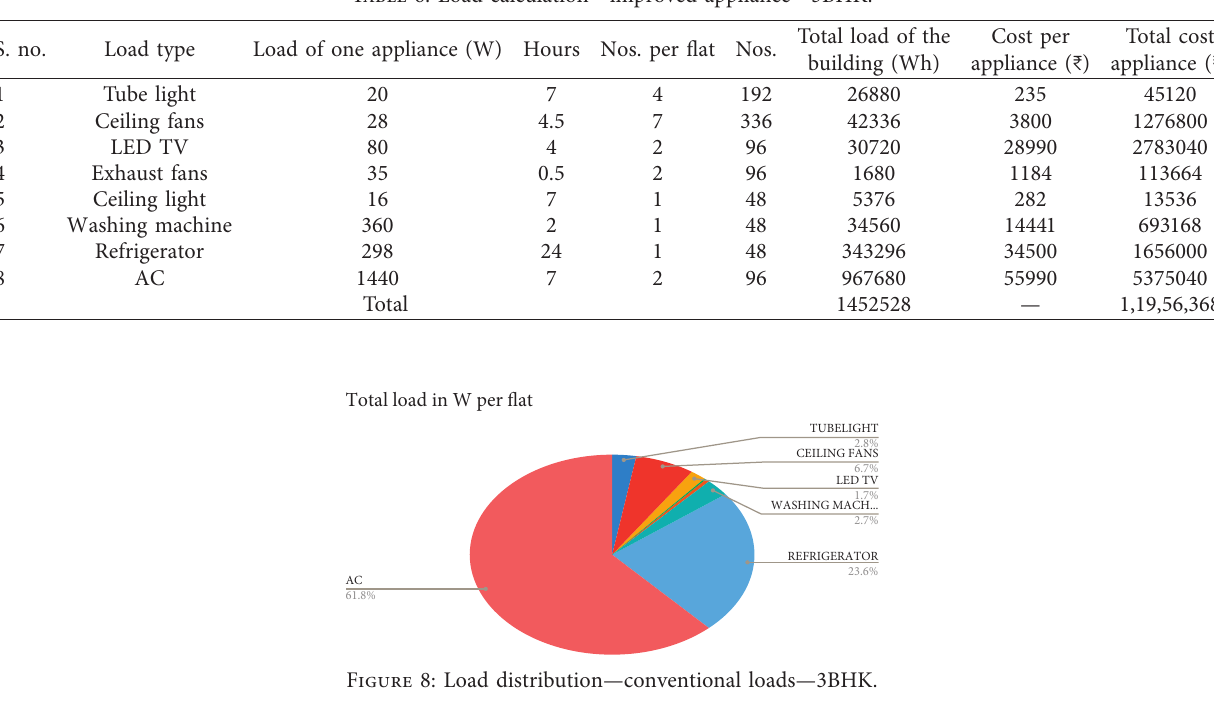
Table 6: Load calculation—improved appliance—3BHK.